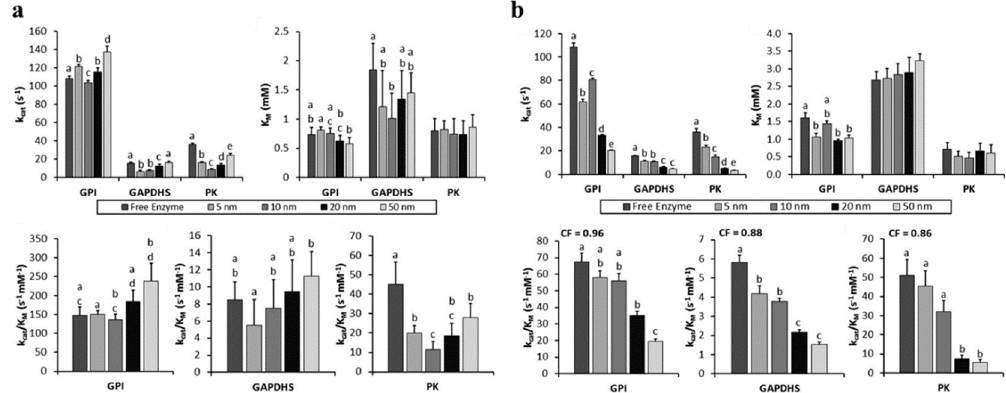
Figure 3. Kinetics of the tethered enzymes as a monolayer and in multilayers. Activity was measured for each enzyme on various sizes of AuNP with varying amounts of substrate. Values for k cat and K M were calculated using Michaelis–Menten kinetics. ( a ) Kinetics of enzymes in a monolayer. The turnover number ( k cat ) displayed no significant trend, irrespective of enzyme type (top left). K M also showed no significant di ff erence for any enzyme as the size of AuNP changed (top right). Both kinetic variables were then utilized to plot enzyme e ffi ciency ( k cat / K M ) yielding no clear trend for change in e ffi ciency as AuNP size increased (bottom); ( b ) Kinetics of multilayer enzymes. The turnover number ( k cat ) decreased as AuNP size increased, irrespective of enzyme type (top left). However, K M showed no significant di ff erence for any enzyme as the size of AuNP changed (top right). Both kinetic variables were then utilized to plot enzyme e ffi ciency ( k cat / K M ) yielding a substantial decrease in e ffi ciency as AuNP size increased with correlation factors as high as 0.96 for GPI. Pearson’s correlation factors (CF) were calculated by using Excel . ( a , b ) Error bars show standard deviation. All comparisons among